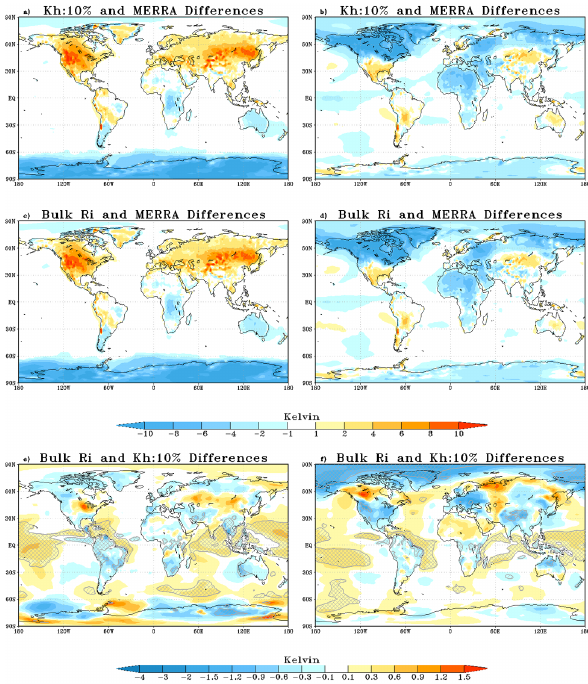
Figure 9. Seasonal mean 2m temperature differences. Method 2 minus MERRA for JJA (a) and DJF (b) , Method 3 minus MERRA for JJA (c) and DJF (d) , and Method 3 minus Method 2 for JJA (e) and DJF (f) . Hatch marks on the bottom plots represent significance at the 90% level using the Student’s t test. Crosshatch marks repre- sent significance at the 95%